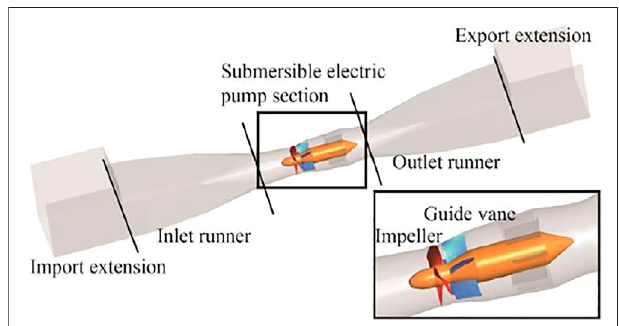
FIGURE 1 | Three-dimensional model of the submersible tubular pump